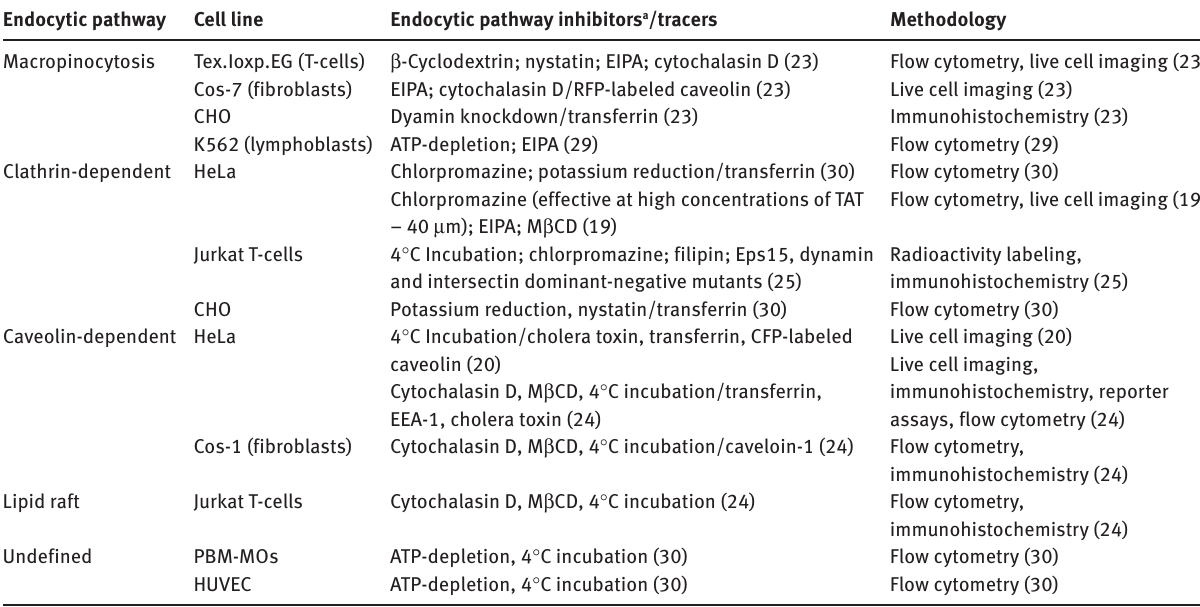
Table 1: Experimental evidence for the use of different endocytic pathways by TAT in different cell lines. Endocytic pathway